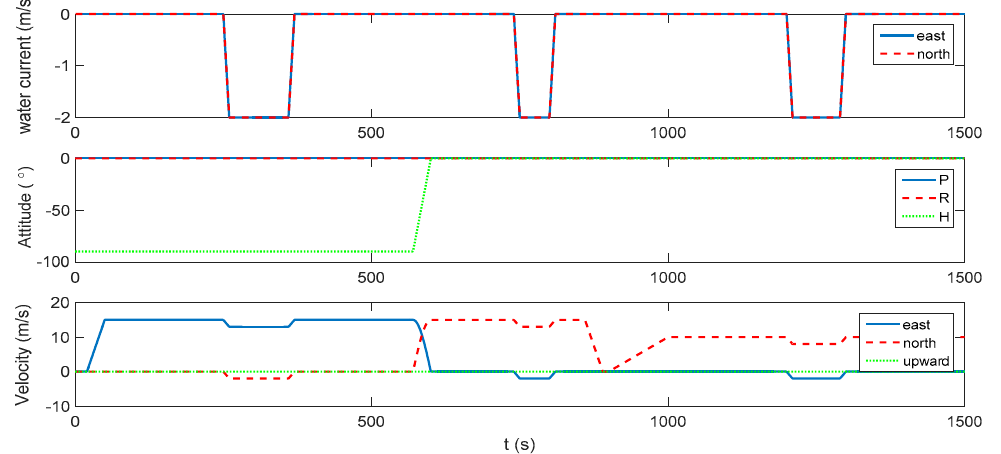
Figure 1. Water current and vehicle dynamics.